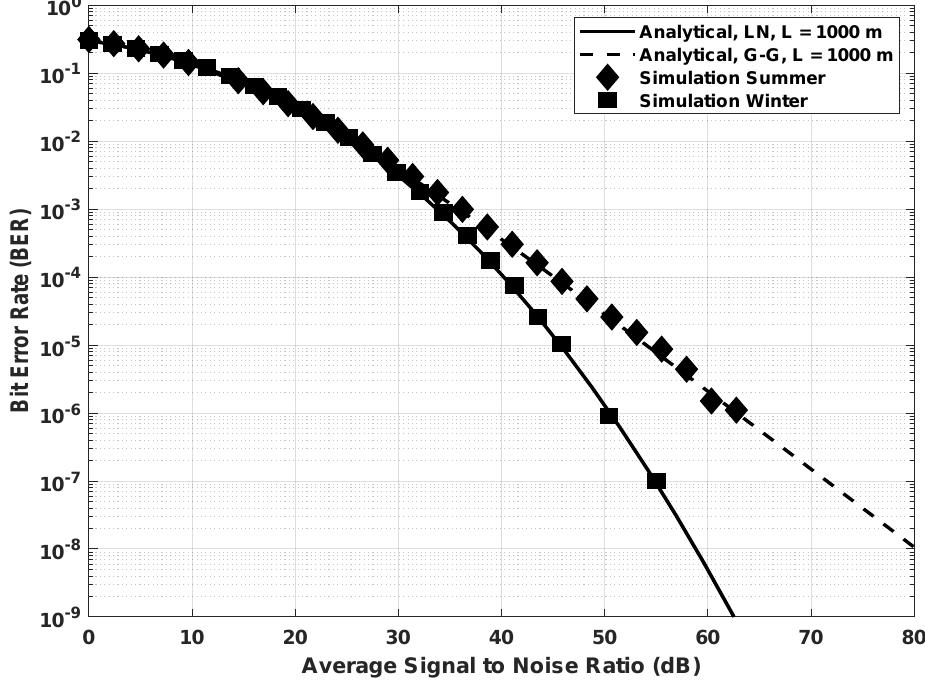
Figure 9. Comparison of BER Determined Analytically and Through Simulations for Gamma–Gamma and Log-Normal